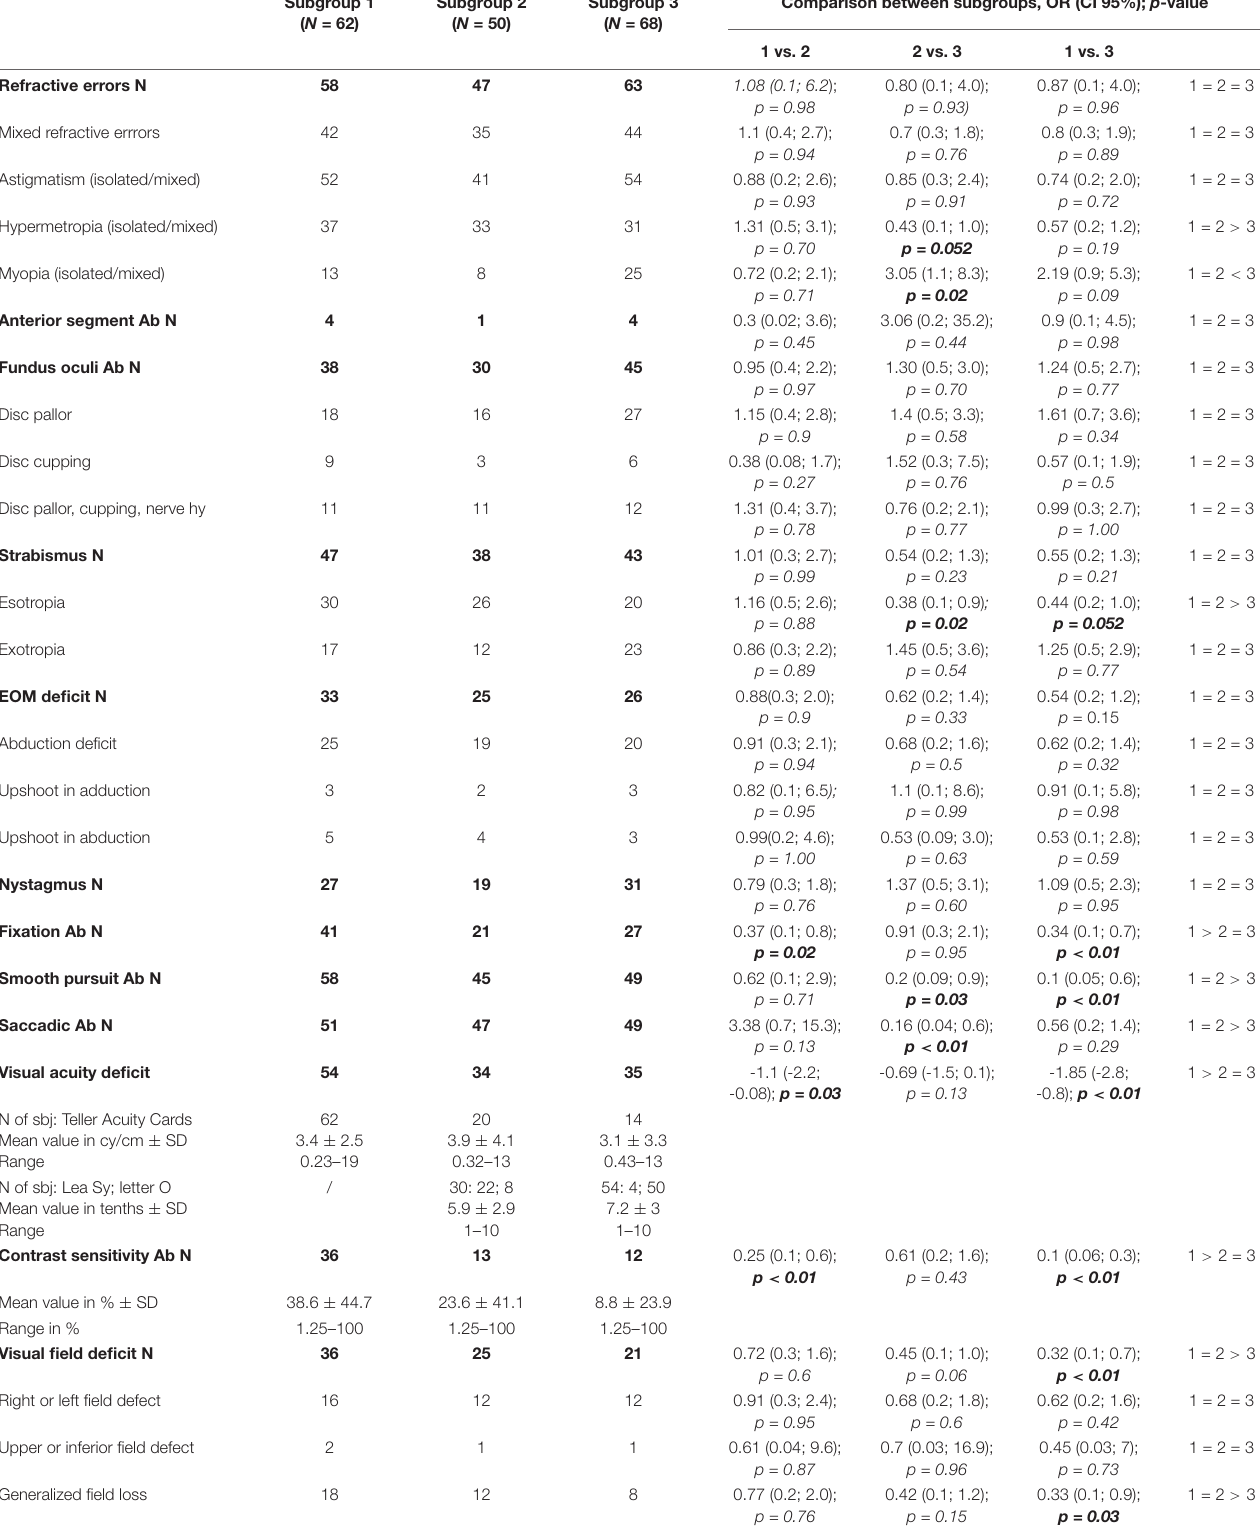
TABLE 2 | Neurovisual profiles between the three subgroups.